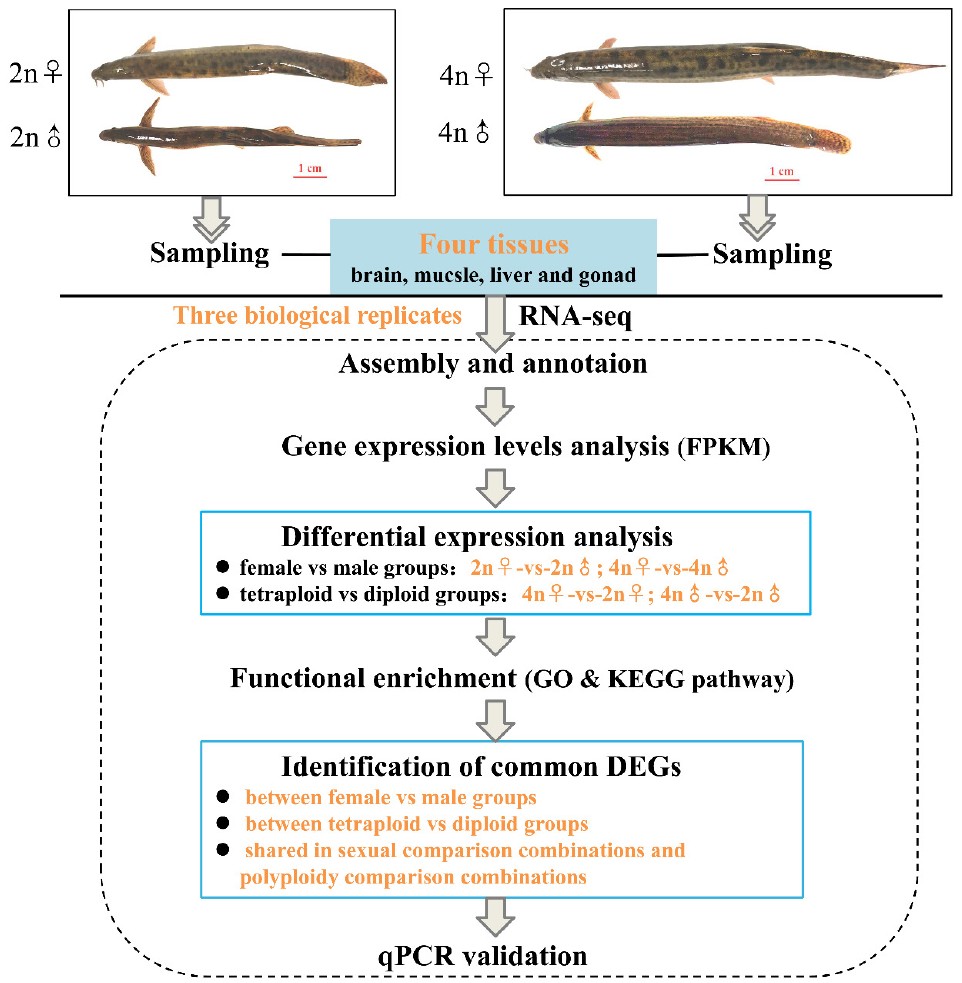
Figure 1. Flow chart of transcriptome sequencing analysis.